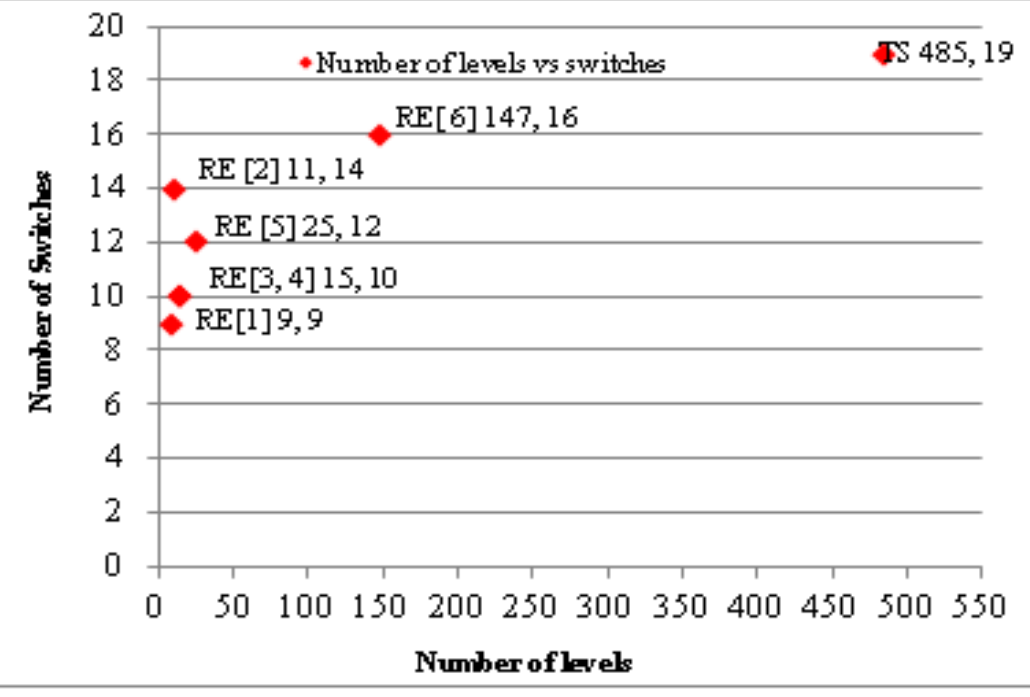
Figure 7. Sketch between the number of output levels and switches.